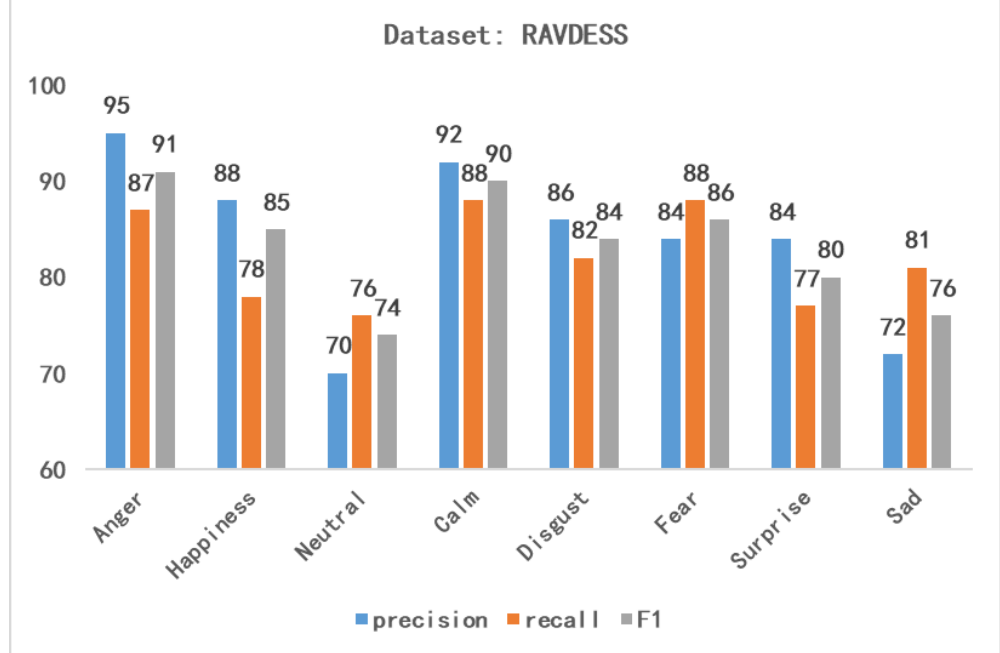
Figure 8. Recognition of different emotions by the proposed